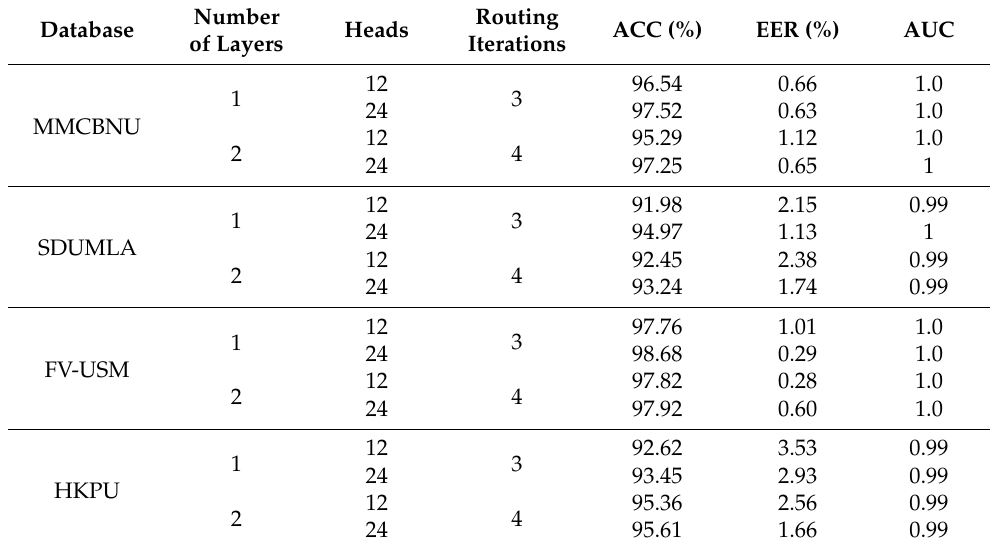
Table 2. Performance comparison of ViT-Cap on four datasets and under different parameter